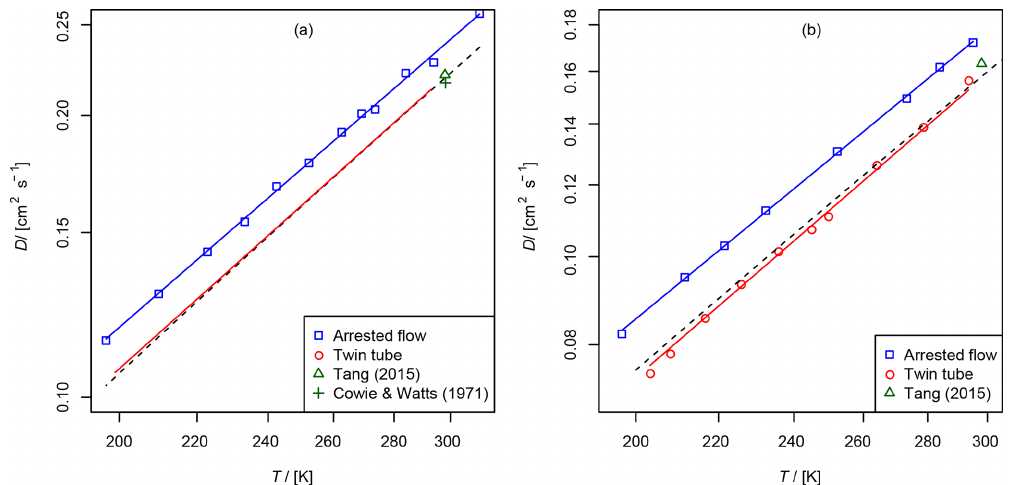
Figure 7. (a) Diffusion coefficient of methane in air, recommended value of D = 0 . 221cm 2 s − 1 at 298K from Tang et al. (2015) and D = 0 . 217cm 2 s − 1 from Cowie and Watts (1971) at 298.2K. For the TT method only the fit function is shown. (b) Diffusion coefficient of ethene in air as a function of temperature, recommended value of Tang et al. (2015) D = 0 . 163cm 2 s − 1 at 298K. The dashed line is calculated using the Lennard–Jones